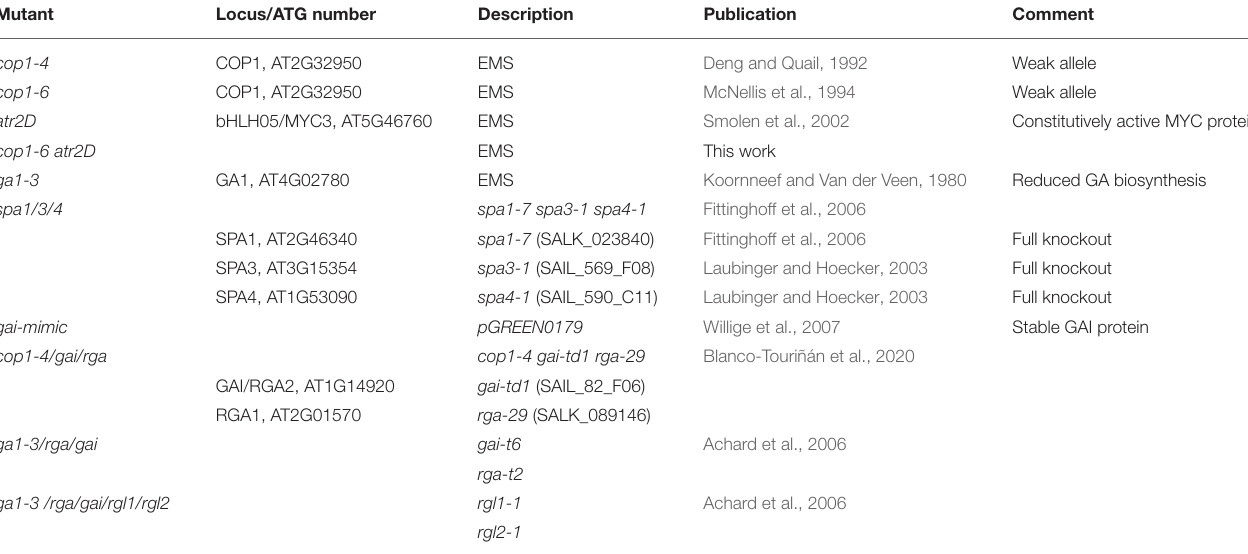
TABLE 1 | Arabidopsis loss-of-function mutants used in this study.